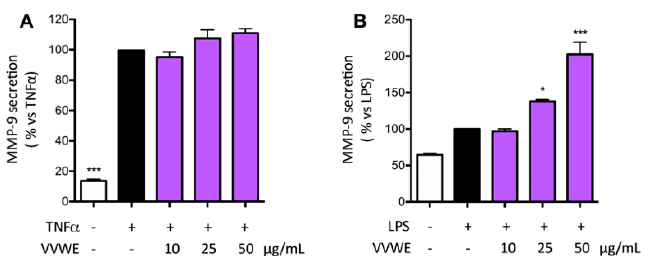
Figure 5. E ff ect of VVWE on MMP-9 secretion induced by TNF- α ( A ) or LPS ( B ). HaCaT cells were treated for 24 h with TNF- α (10 ng / mL) or 30 h with LPS (5 µ g / mL) and VVWE (10–50 µ g / mL). Matrix metalloproteinase-9 (MMP-9) release was evaluated by the ELISA assay. The graphs show the means ± SD of at least three experiments performed in triplicate. Statistical analysis: one-way ANOVA, followed by Bonferroni’s post hoc test. * p < 0.05, *** p < 0.001 vs. TNF- α alone. EGCG (20 µ M) was used as the reference compound of TNF- α or LPS-induced MMP-9 secretion (38.0% and no inhibition, respectively).